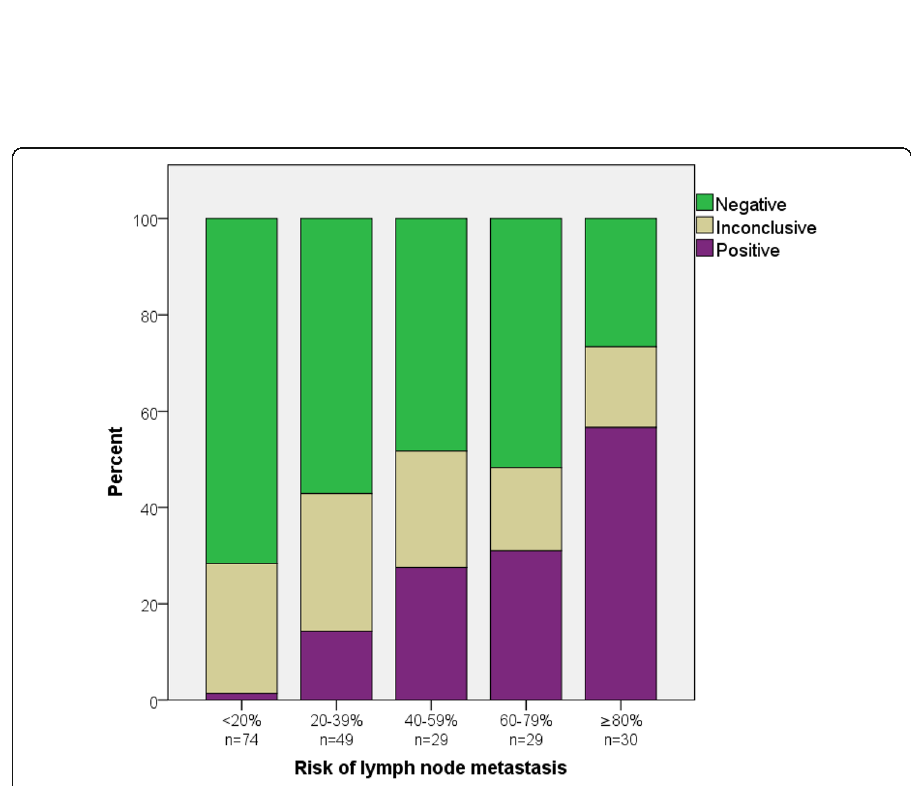
Fig. 3 The relative proportion of the results of the choline PET/CT scans grouped by the risk of lymph node metastasis according to the Briganti nomogram (Briganti et al., 2012). Two patients who were diagnosed with transurethral resection of the prostate are not